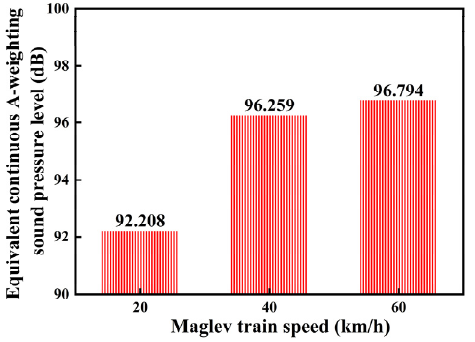
Figure 5. Average value of the equivalent continuous A-weighting sound pressure levels of ten measuring points at the three speeds. Table 1. Equivalent continuous A-weighting sound pressure levels of different measurement points at the three speeds (unit: dB).